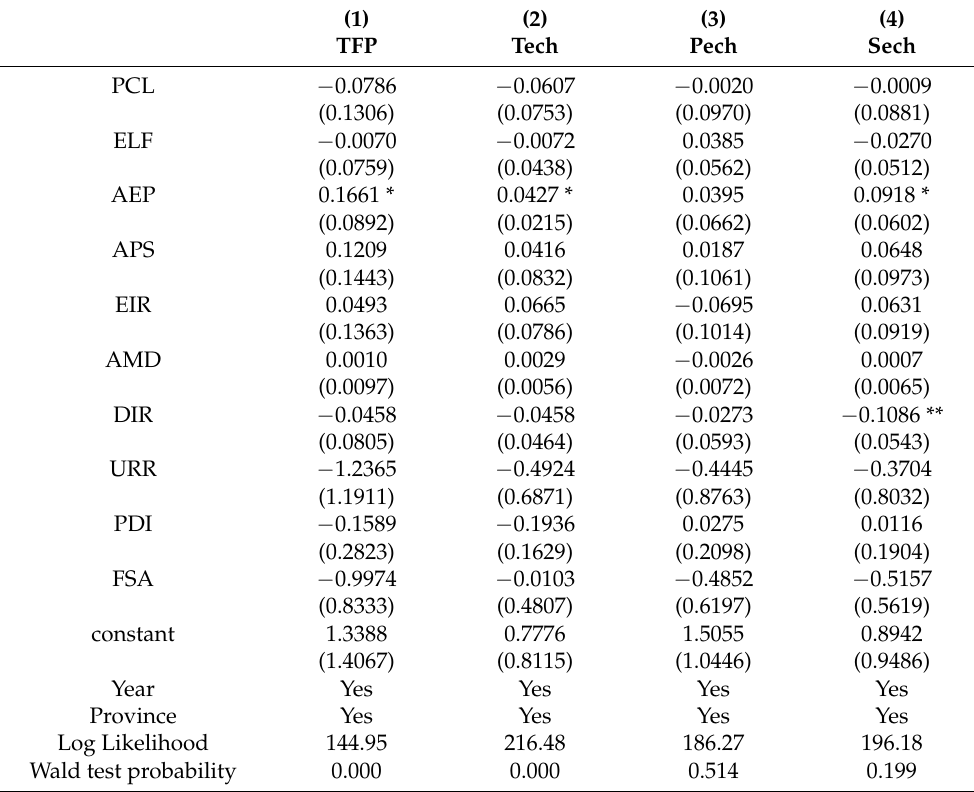
Table 8. Factors Influencing Production Efficiency and Its Decomposition Index of Medium Indica Rice.